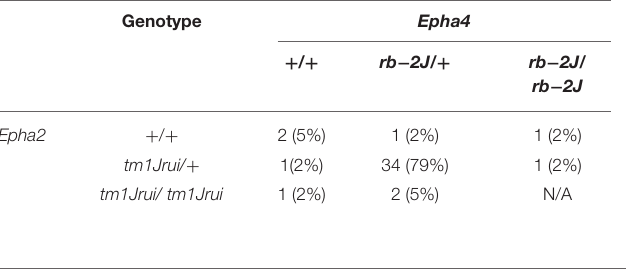
TABLE 2 | The phenotypic breakdown of the double heterozygotes Epha2 tm1Jrui/+ Epha4 rb-2J/+ crosses in 5litters harvested at E11.5.